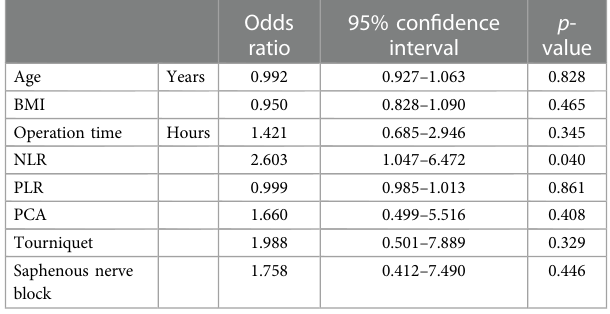
TABLE 3 Univariate logistic regression analysis of factors associated with the occurrence of PONV in patients with hemophilia A.